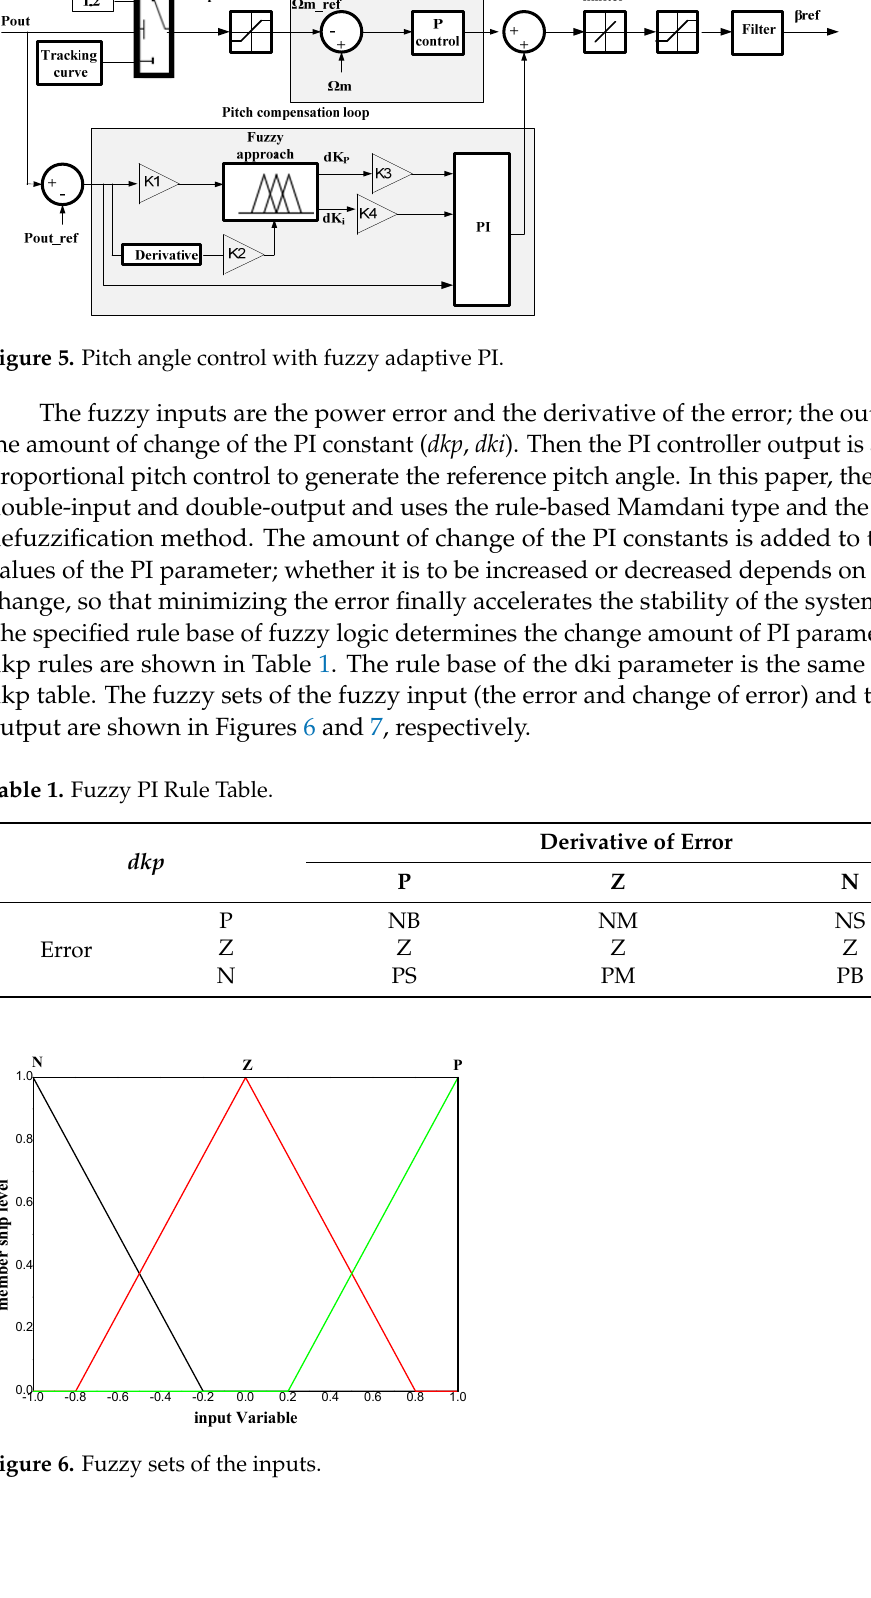
Figure 7. Fuzzy sets of the outputs. The error and the change of the error of output active power, which are the inputs to the fuzzy, are calculated as follows [39,40]: ( )